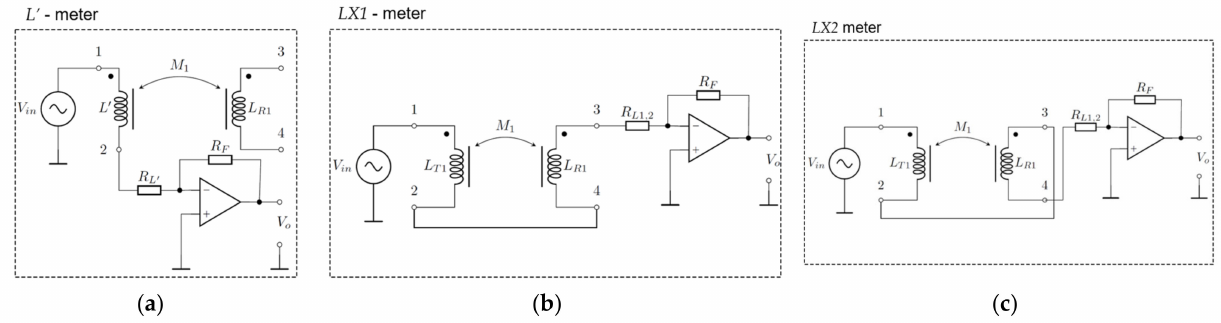
Figure 8. Mutual inductance measurement circuit: ( a ) measurement of coil inductance L (cid:48) ; ( b ) measurement of inductance L X 1 ; ( c ) measurement of inductance L X 2